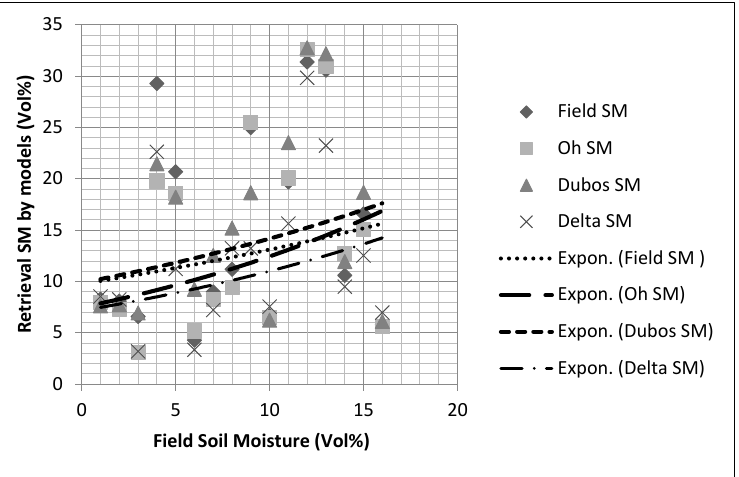
Figure 12. The graph shows the relationship with field soil moisture (Vol%) and retrieval soil moisture for the three models: Oh, Dubois, and delta.